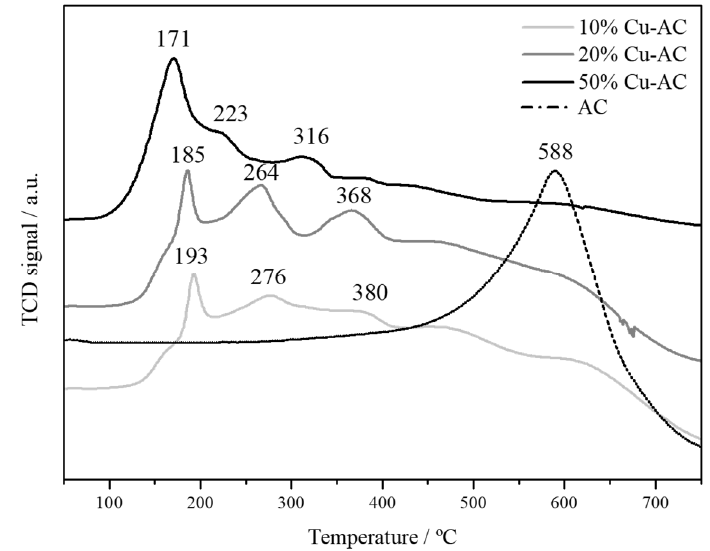
Figure 1. Temperature-programmed reduction (TPR) profiles of the fresh catalysts and the activated carbon support. carbon